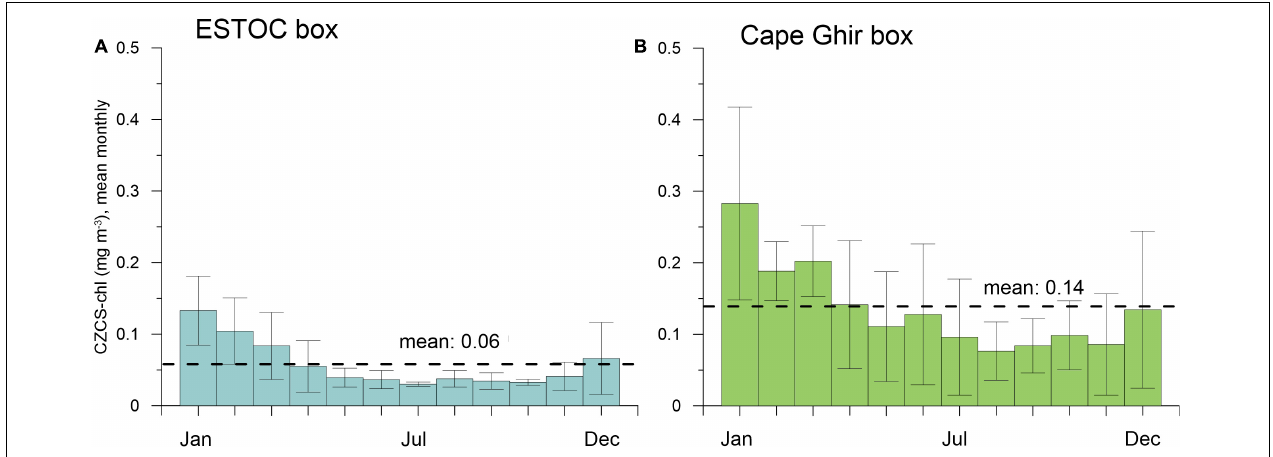
FIGURE 3 | Mean monthly chlorophyll (mg m − 3 ) from the satellite-CZCS sensor from 1979 to 1985 [Davenport et al. (1999) for ( A ) the ESTOC box and ( B )] the Cape Ghir box. Annual means are shown by stippled lines. Values decline thereafter to a minimum in summer and increase again at the end of the year. Annual means are given as well. A distinct summer maximum at the Cape Ghir box (from SeaWiFs, Figure 2 ) cannot be found in these old CZCS records (B) .